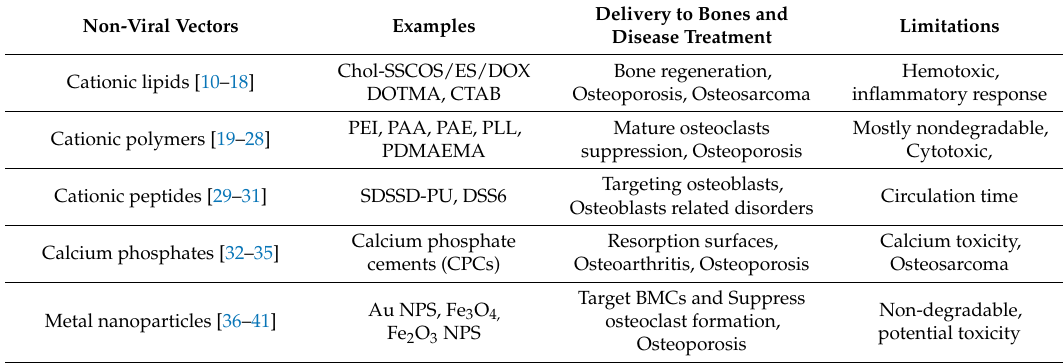
Table 1. Non-viral vectors as delivery systems against different bone disorders.